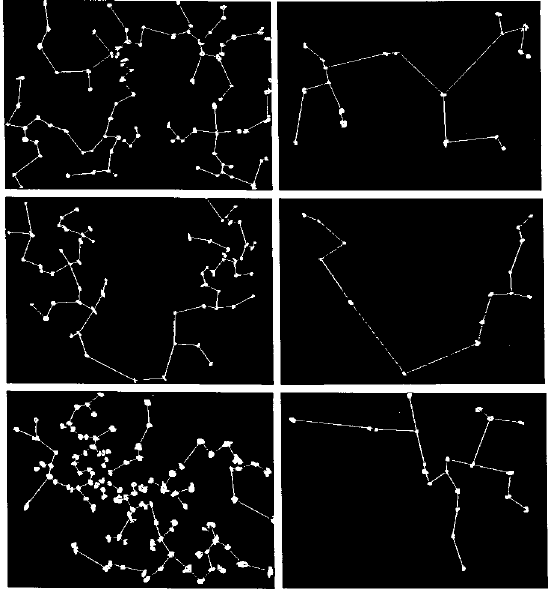
Fig. 2. “Minimal Spanning Tree” (MST) displays of neuronal pat- terns in a 41 year-old female with familial presenile AD (right col- umn), compared with an age-matched male control case (left col- umn). Top: NCS (left = CO: MSNE = 89, MMEL = 36.7 pixel; right = AD, MSNE = 18, MMEL = 73.3 pixel). Middle: NRD (left = CO: MSNE = 62, MMEL = 38.5 pixel; right = AD:MSNE = 14, MMEL = 73.9). Bottom: LC (left = CO: MSNE = 110, MMEL = 29.1 pixel; right = AD: MSNE = 23, MMEL = 56.2 pixel). (MSNE number of edges, MMEL mean edge